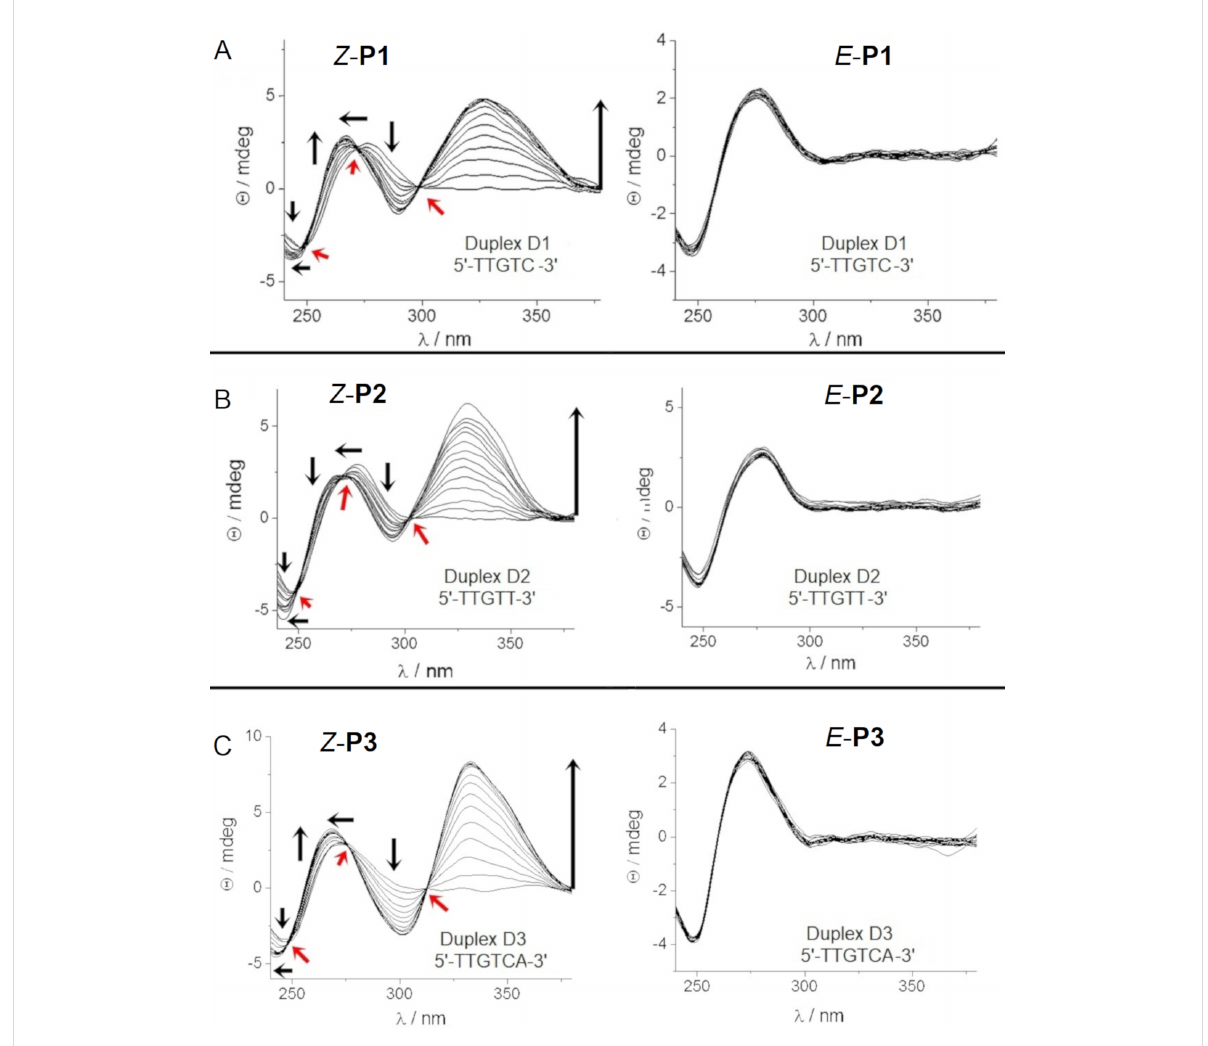
Figure 3: Titration experiments of target DNA sequences with P1–P3 in the photostationary Z- state and the thermal E -state. See Table 1 for the com- plete sequences.